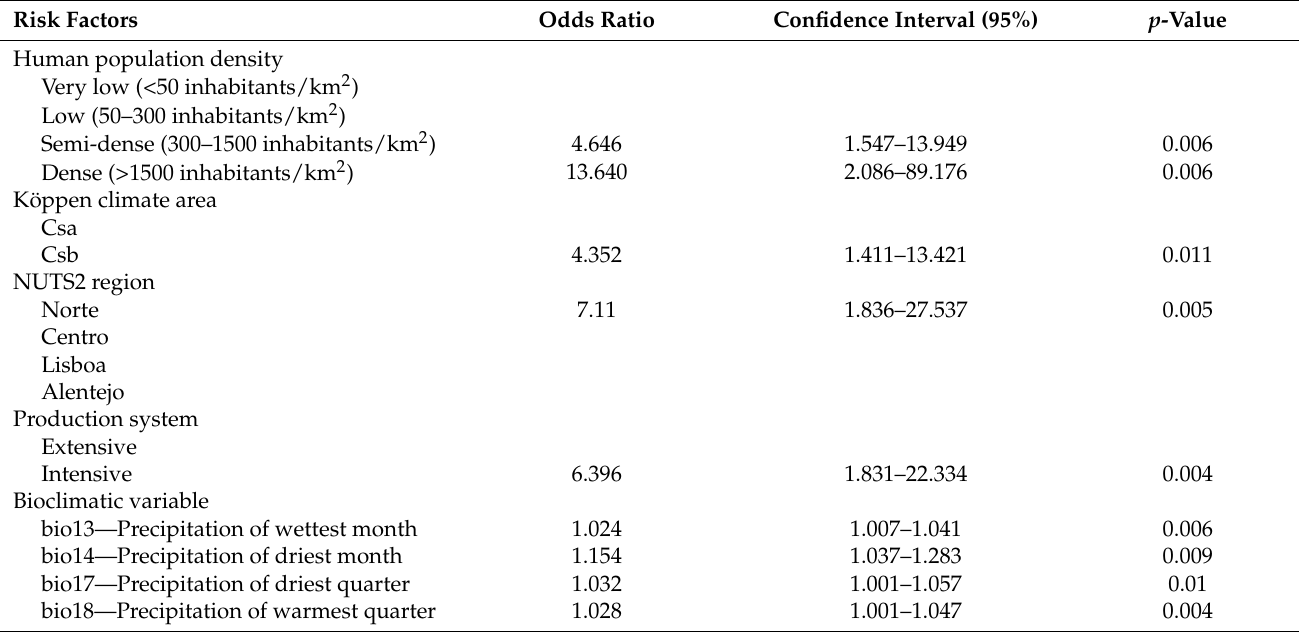
Table 2. Univariate GLMM results for Neospora caninum seroprevalence. Farm ID was included as a random effects